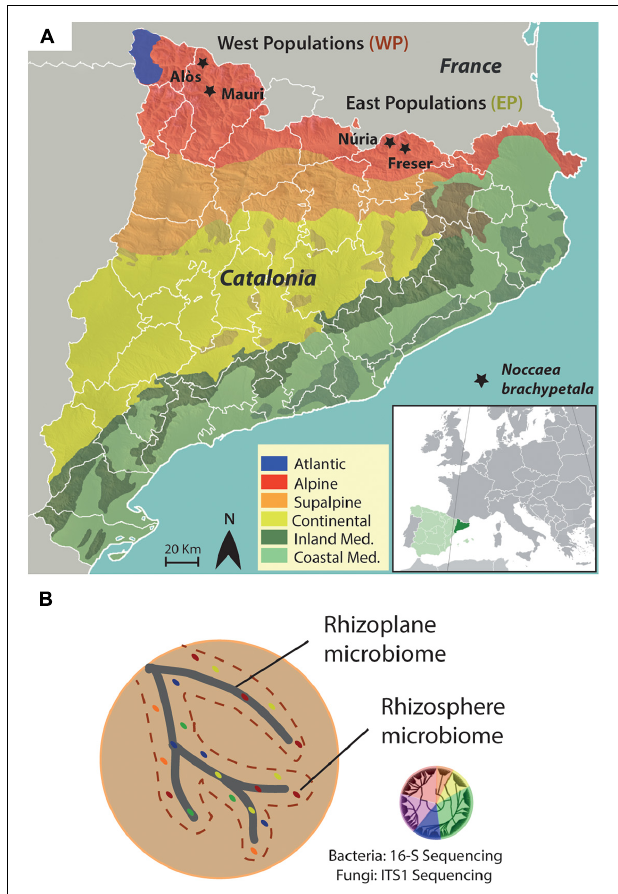
FIGURE 1 | Experimental design. (A) Climatic map of Catalonia with the sampling locations of plants and soils indicated by stars. Western populations are composed form locations of Alòs and Mauri, whereas Eastern populations are from Núria and Freser. (B) Schematic drawing of the analyzed compartments of the root. DNA of the microbiome from the rhizoplane and rhizosphere was extracted followed by 16S and ITS sequencing of the bacteria and fungi,